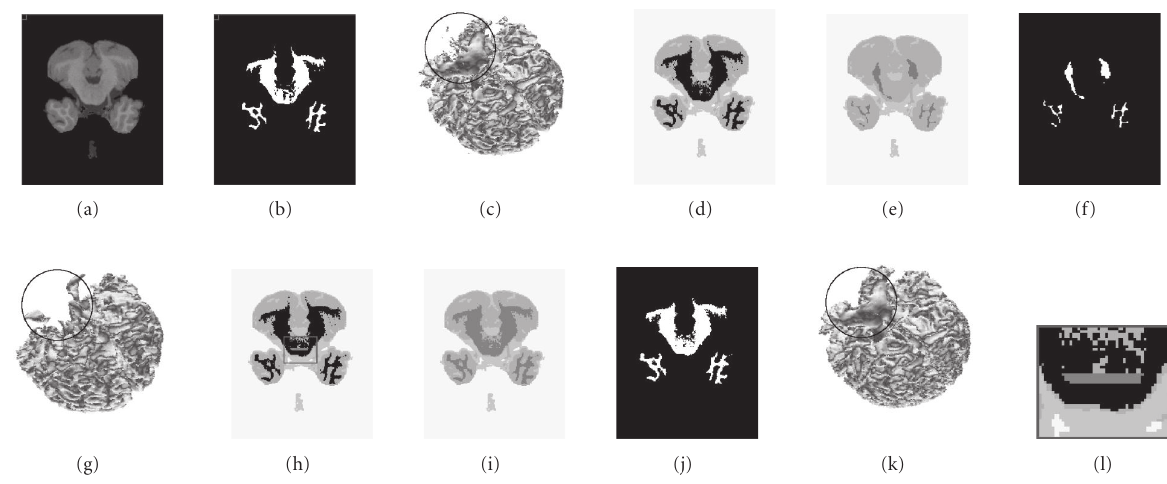
Figure 13: Simple user interaction can improve the segmentation accuracy dramatically (see text). (a) One slice of the original 3D brain image, (b) the ground truth data of WM tissue in the slice shown in panel (a), (c) the corresponding 3D model of ground truth data of WM tissue, (d) based on histogram analysis, the whole brain is divided into GM tissue, WM tissue, CSF tissue with di ff erent gray values, and unlabeled tissues in active regions with the most black values, (e) the segmentation result by using dual-front active contours, (f) the segmented WM tissue (the white part), (g) the 3D model of segmented WM tissue, (h) manually added seed points for WM tissue, (i) the new segmentation result with added seed points, (j) the segmented WM tissue, (k) the corresponding 3D model of the segmented WM tissue, (l) the horizontal line is the zoom-in of the user-added seed points in panel